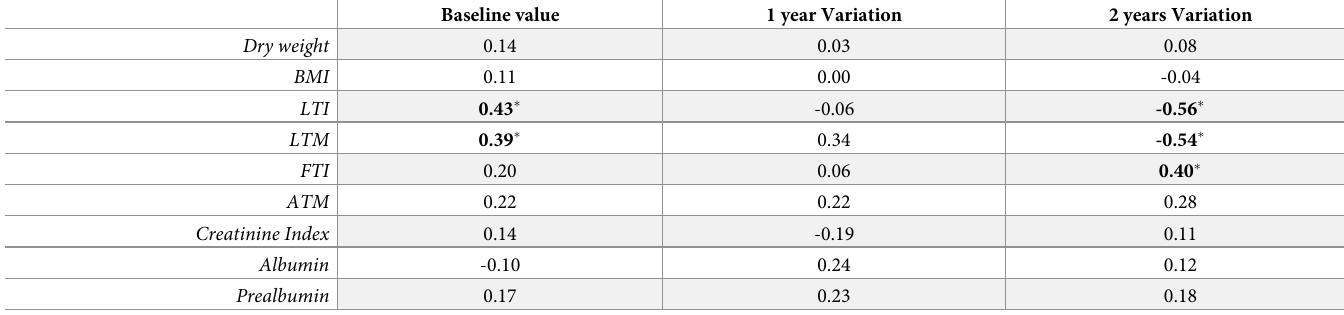
Table 3. Pearson correlation coefficient between c20S Proteasome at baseline and nutritional markers.